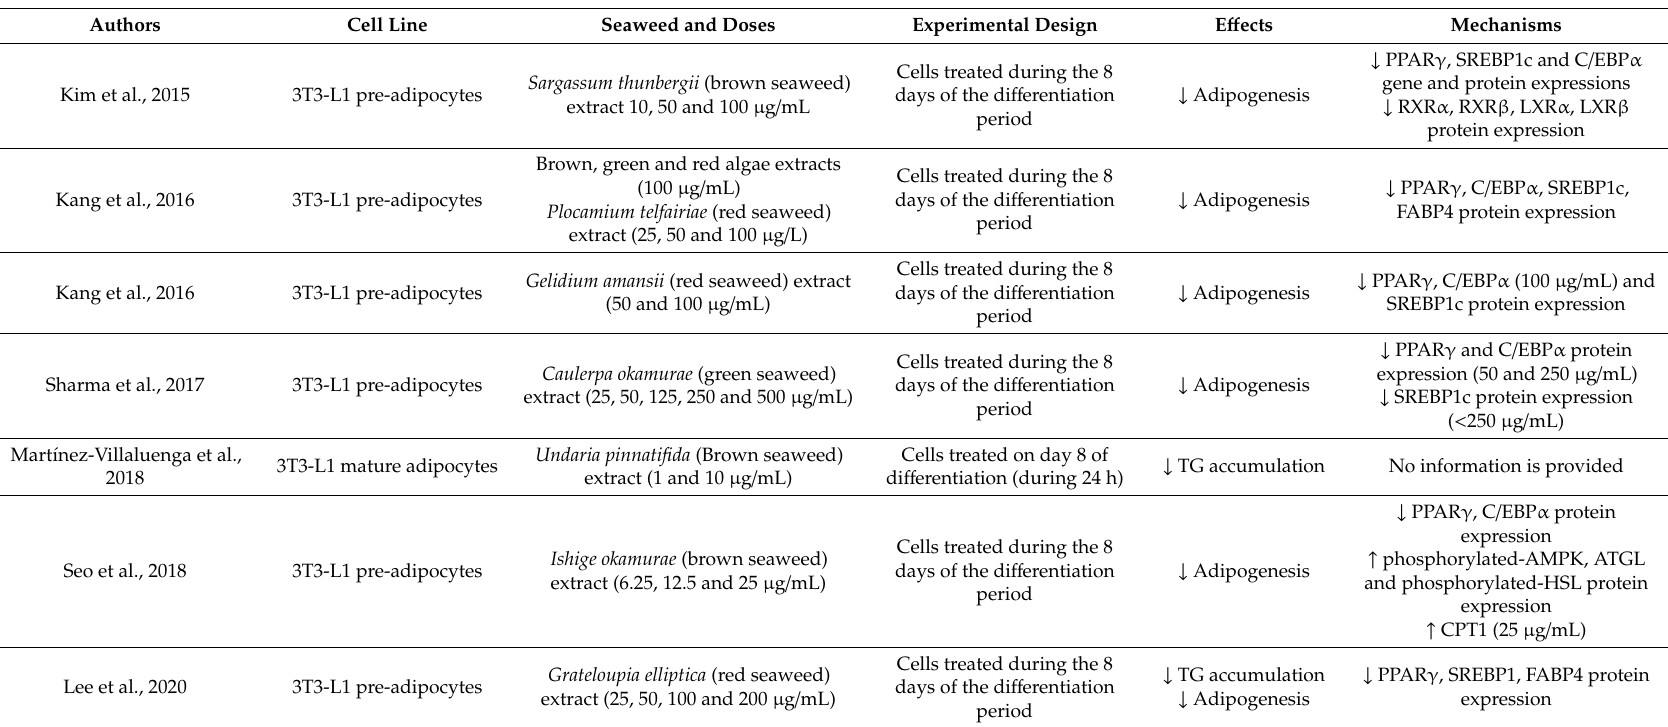
Table 1. E ff ects of seaweeds in 3T3-L1 pre-adipocytes and mature